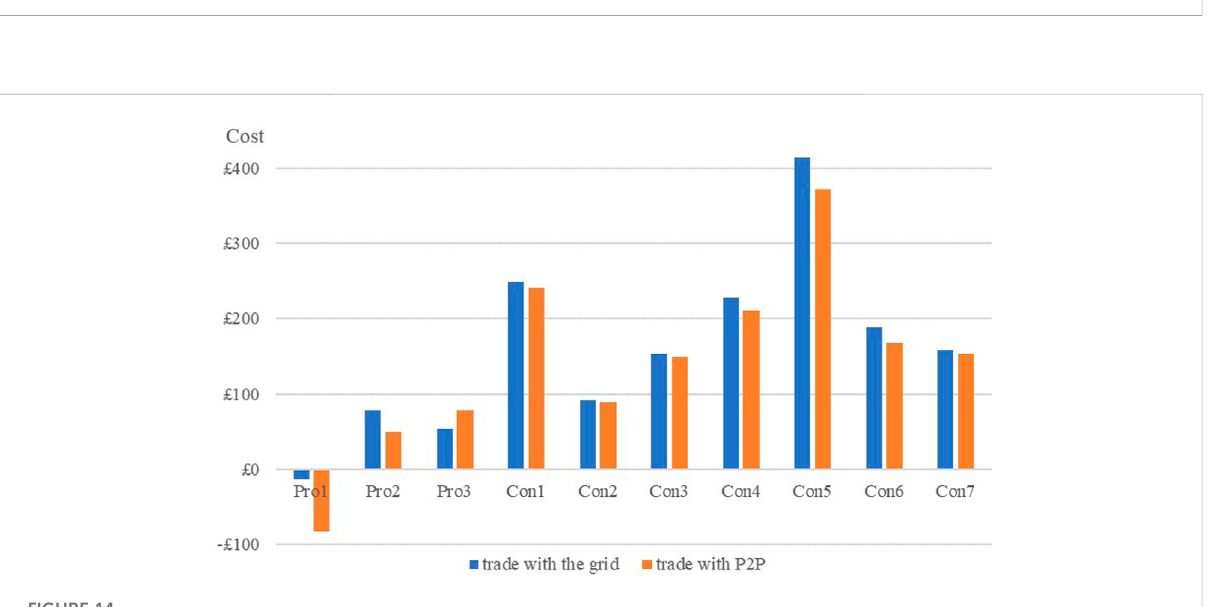
FIGURE 13 Electricity deviation of standardizing consumers.